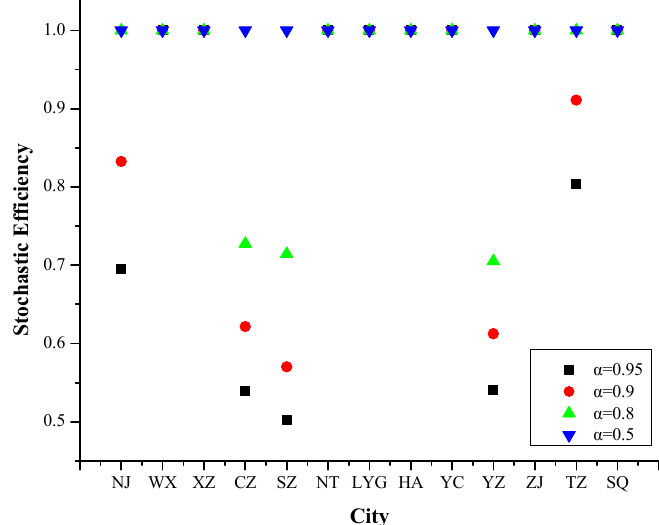
Figure 3. Stochastic efficiency values of 13 cities in Jiangsu Province at different risk levels in 2014.